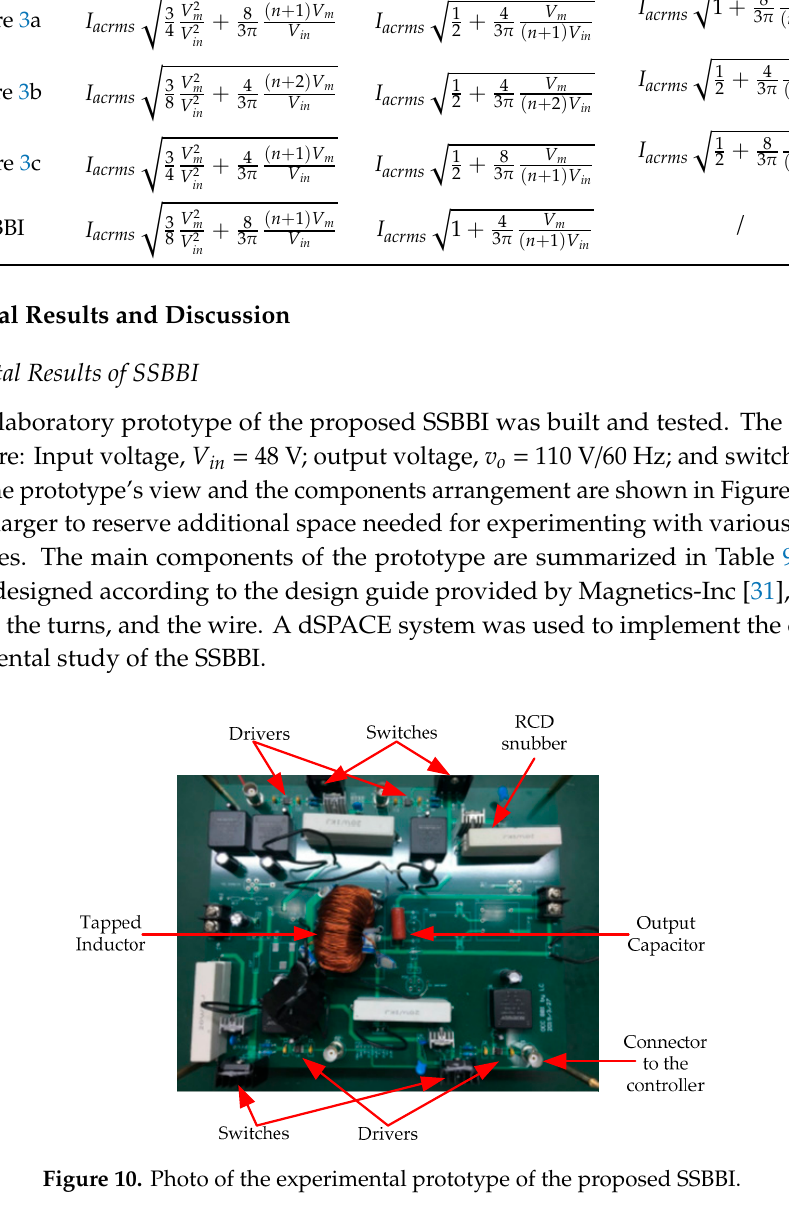
Table 8. Comparison of the RMS current stress.